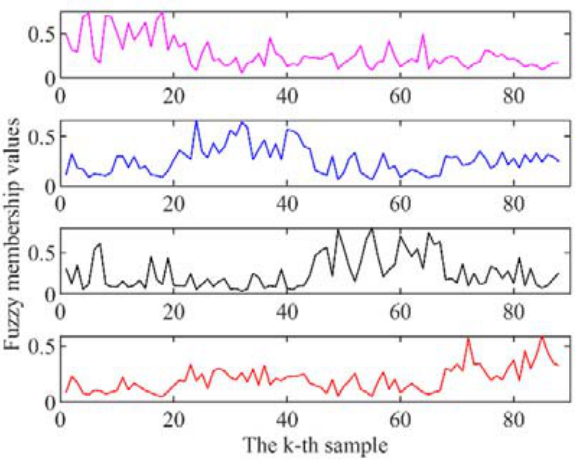
Figure 4. The fuzzy membership values of samples. From top to bottom, the four subplots represent the samples’ membership values belonging to the four classes. The top (control group) does not have any pesticide residues on the cabbage leaf sample. The ratio of lambda-cyhalothrin and water is 1:500, 1:100,